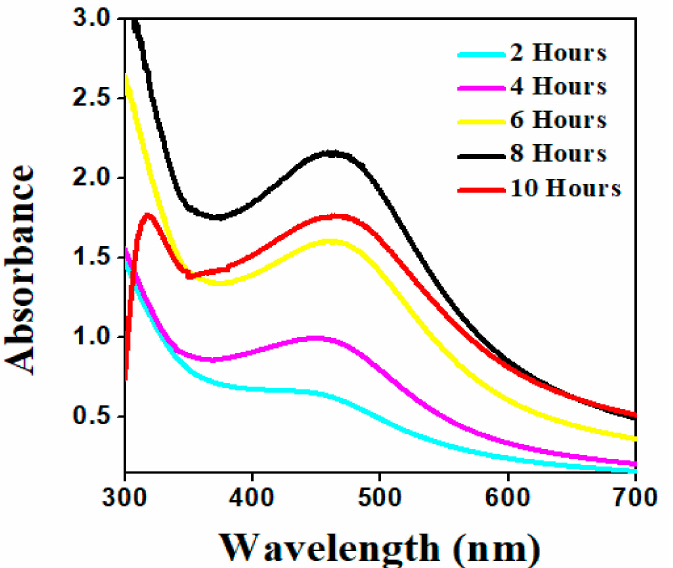
Figure 5. Absorption spectra of AgNPs obtained at different time